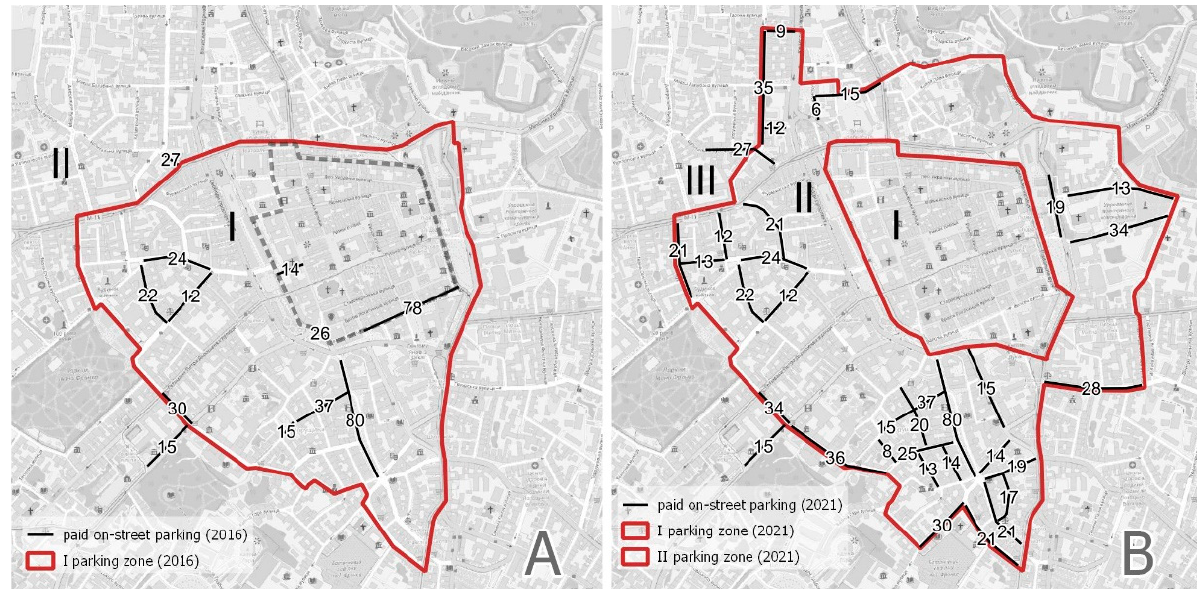
Figure 6. The charged on-street parking spaces in 2016 ( A ) and 2021 ( B ), based on Lviv City Council data [51,52]. Schemes by R. Liubytskyi.